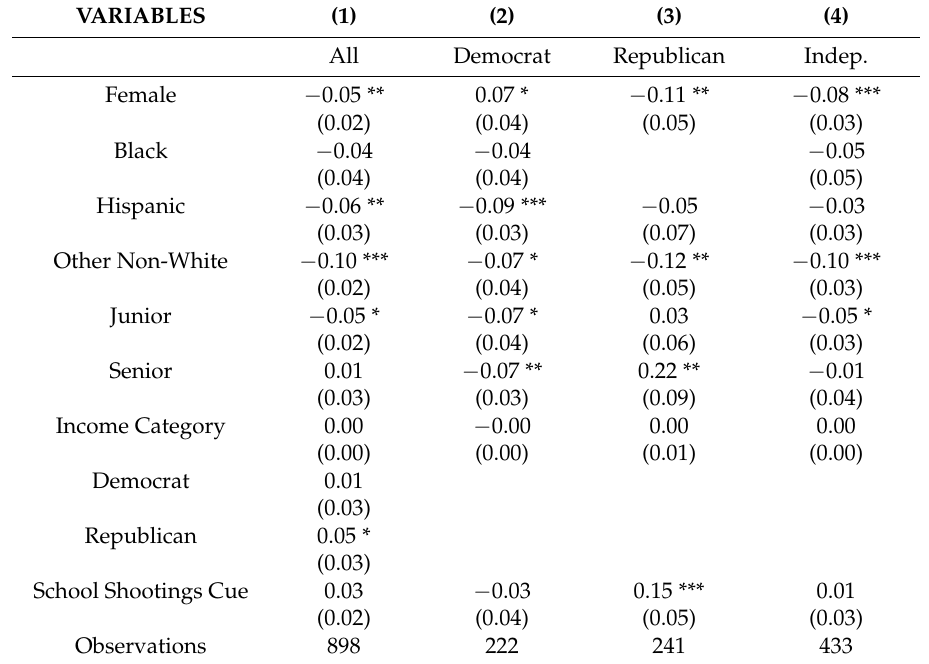
Table 5. Emotional cues and attitudes towards arming citizens. Probits: dependent variable equals one if strongly agree with the statement that “a greater presence of armed citizens would reduce the risk of mass